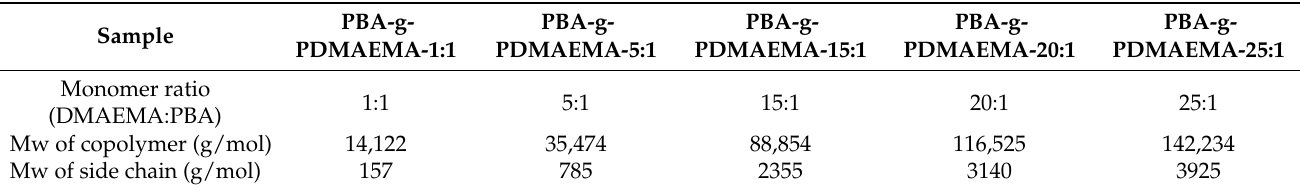
Table 2. Molecular weights of